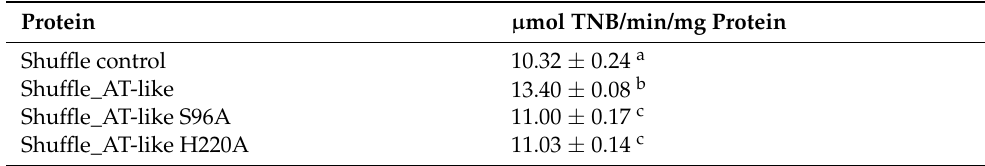
Figure 3. Thioesterase activity of AT-like domain toward four acyl-CoA substrates. Values are reported as means ± standard deviations for three biological replicates. Means with different letters are statistically different according to a one-way ANOVA test ( p < 0.05) with multiple comparisons. Means between SHuffle and SHuffle AT-like activities are statistically different according to an unpaired t -test at p < 0.05 (**), p < 0.01 (***), and p < 0.001 (****). Table 2. Thioesterase activity of the mutant AT-like domain towards docosahexaenoyl-CoA (DHA-CoA).